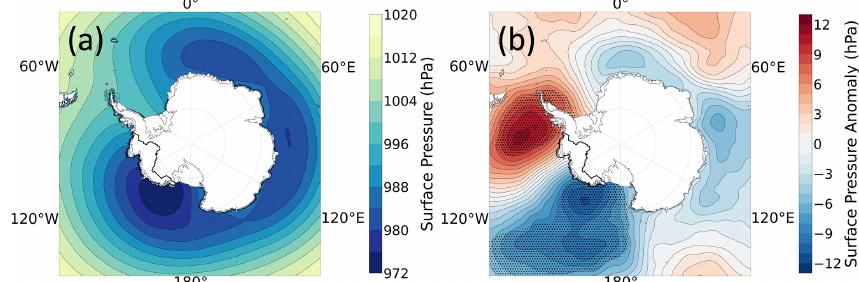
Figure 4. MERRA-2 composite maps of (a) surface pressure and (b) surface pressure anomaly during AR landfall in the region of interest (the Amundsen Sea Embayment and Marie Byrd Land) which is outlined in black. Stippling on the surface pressure anomaly indicates regions of statistically significant anomaly, where the anomaly exceeds one half of the standard deviation from the mean surface pressure.